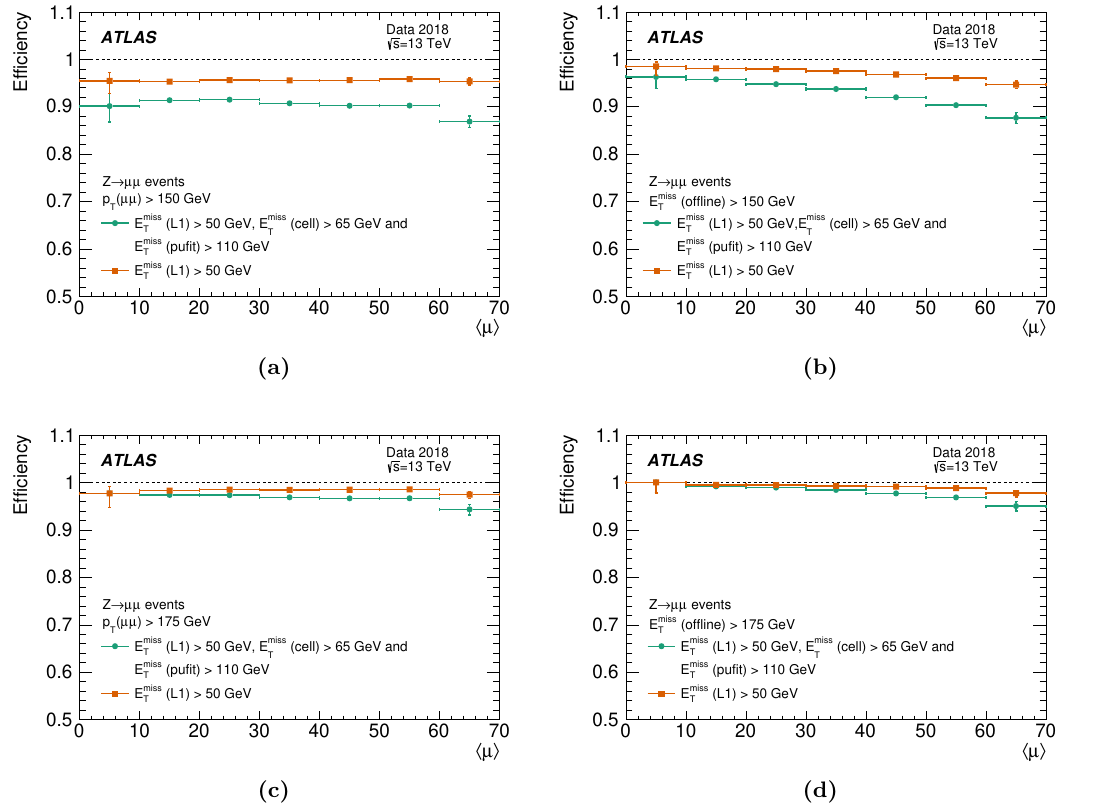
Figure 8. E(cid:14)ciencies for Z ! (cid:22)(cid:22) events are shown for the L1 E miss > 50 GeV trigger (square) T and for the complete L1+HLT trigger chain (circle) that also requires pufit E miss > 110 GeV. The T uncertainties are statistical. Each is shown as a function of h (cid:22) i , either for a p T ( (cid:22)(cid:22) ) threshold as in the left plots: (a) and (c) or for an o(cid:15)ine E miss threshold as shown in the right plots: (b) and (d). T The upper two plots (a) and (b) show thresholds of 150 GeV, while the lower two plots (c) and (d) correspond to thresholds of 175